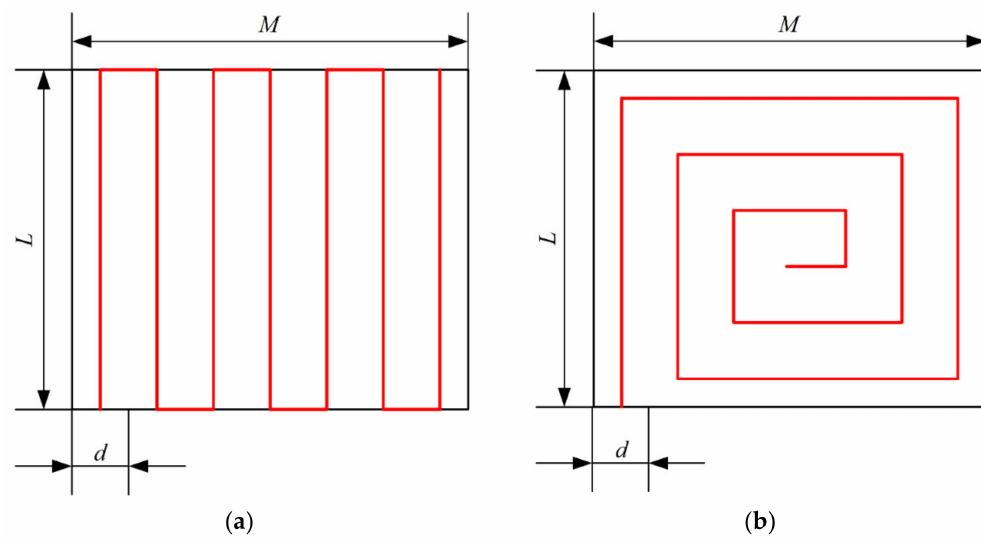
Figure 2. Two methods of covering the operation region: ( a ) reciprocating traversing method; ( b ) square spiral method. The black rectangle is the operation region and the red lines represent the route; parameter d denotes the spraying swath